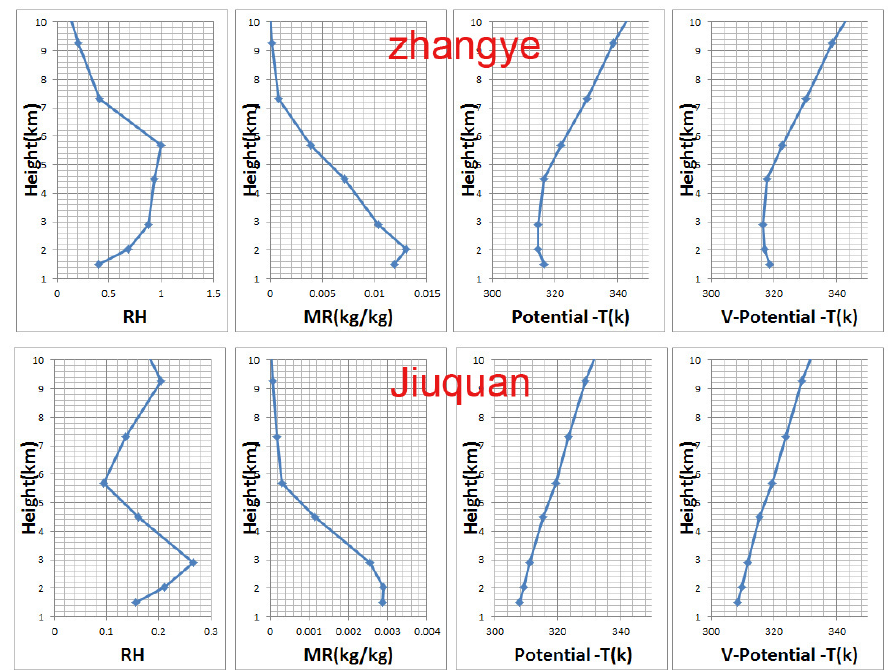
Figure 2. Profile of primary and conserved variables retrieved from MODIS atmospheric profile data for Jiuquan and Zhangye radiosonde stations on 10 August 2012.